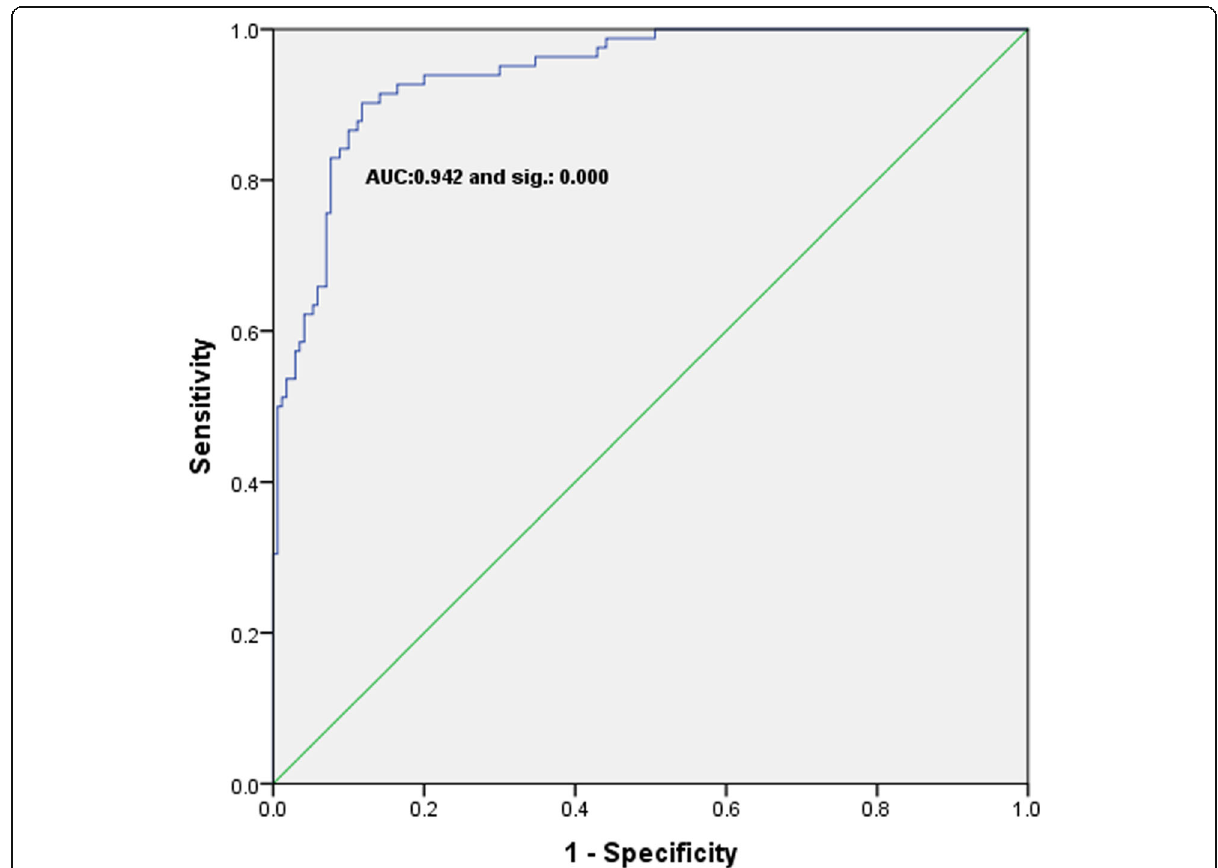
Fig. 4 ROC curve for the predicted probability of the proposed model